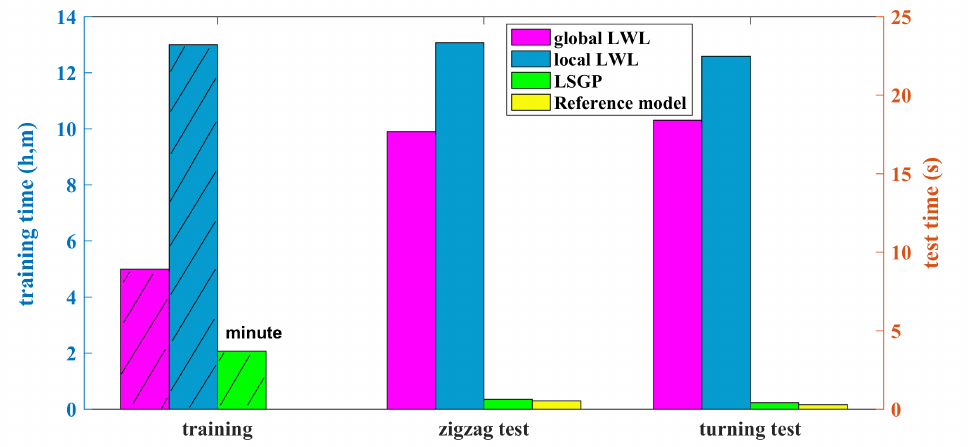
Figure 10. Compare of time spent by different methods. The training part (filled with diagonal lines) refers to the left vertical axis, the variable unit is hours, especially the time unit of LSGP is minutes; the test part refers to the right vertical axis, the unit is